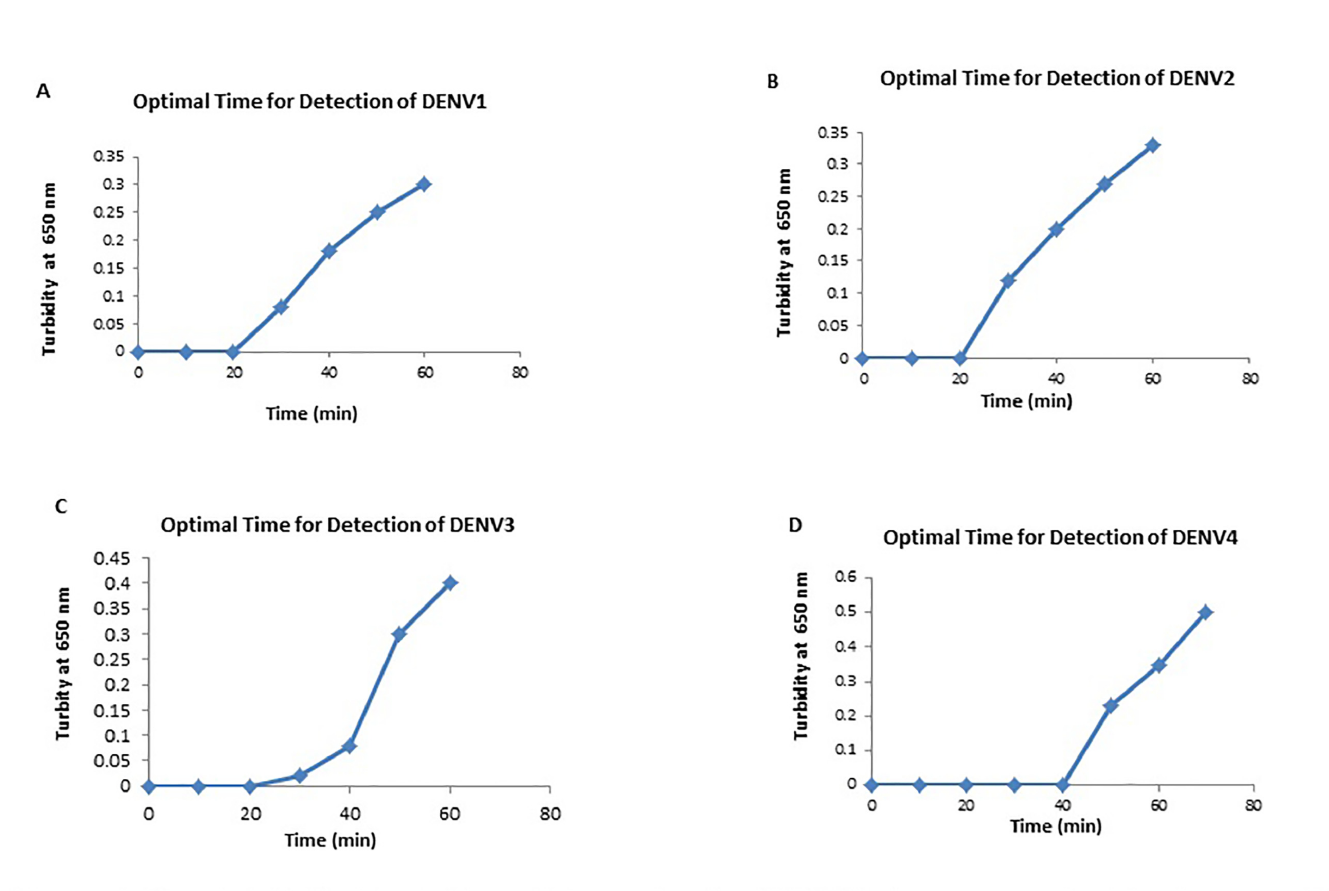
Fig 2. Optimal time of detection for DENV 1, DENV 2, DENV 3 and DENV 4 serotypes. Panel A-C: optimal time of detection for DENV 1 – 3 serotypes is 30 min; panel D: optimal time of detection for DENV 4 serotype is 45 min.